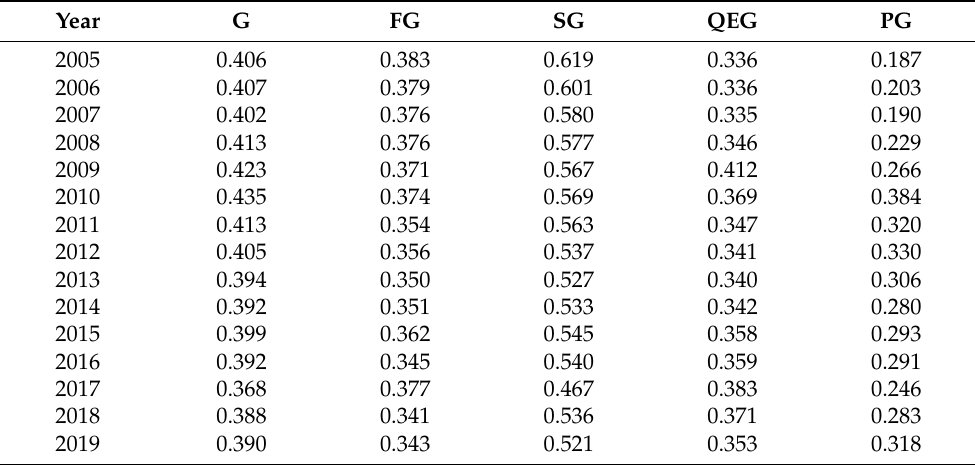
Table 5. Gini coefficient of development of open Economy in YRDA from 2005 to